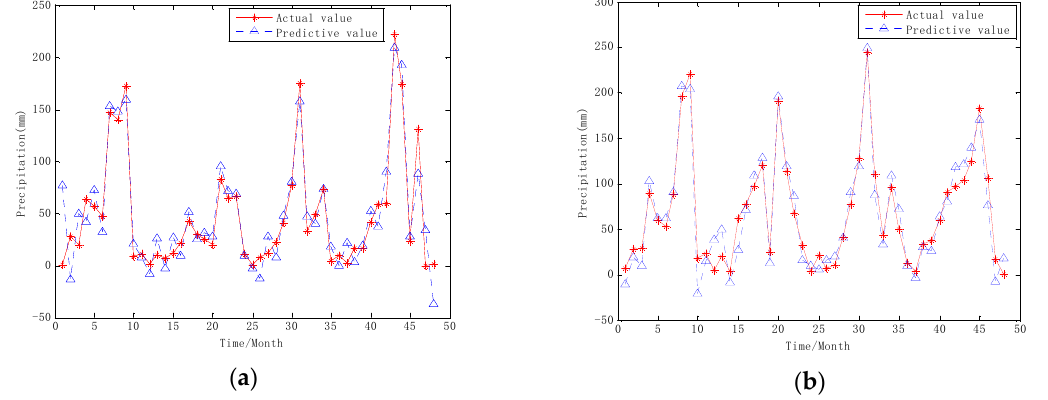
Figure 6. The monthly precipitation time series prediction results of hybrid VMD-ELM model. ( a ) Yan’an; ( b ) Huashan.